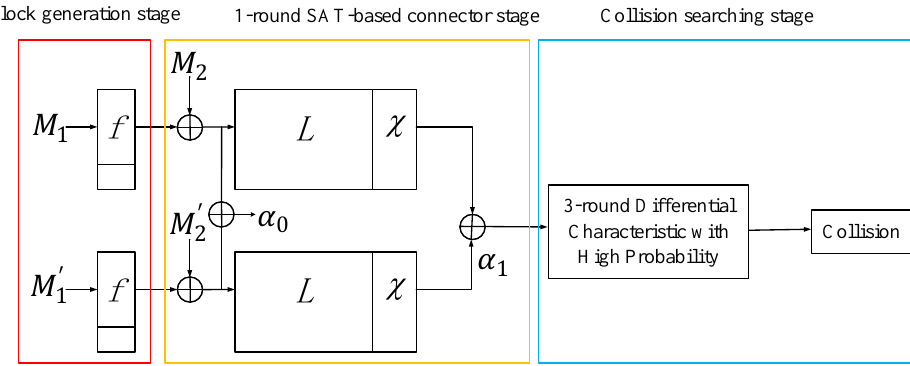
Figure 3: Framework of our